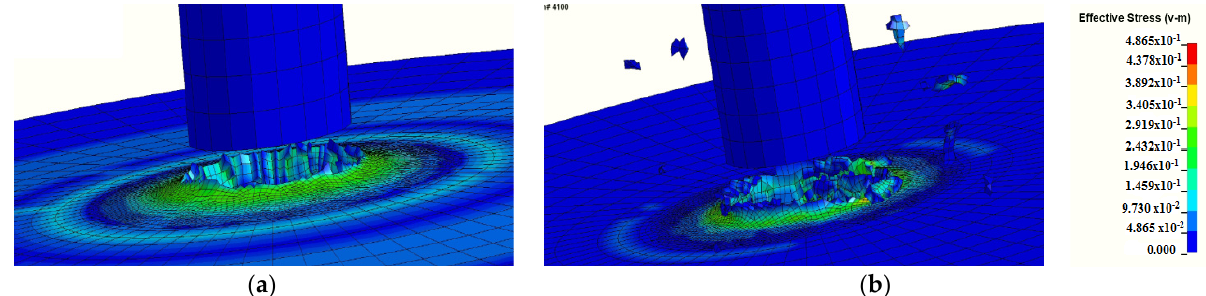
Figure 12. Failure through plugging of 3.18 mm target thickness for an impact velocity of ( a ) 200 m/s and ( b ) 900 m/s.